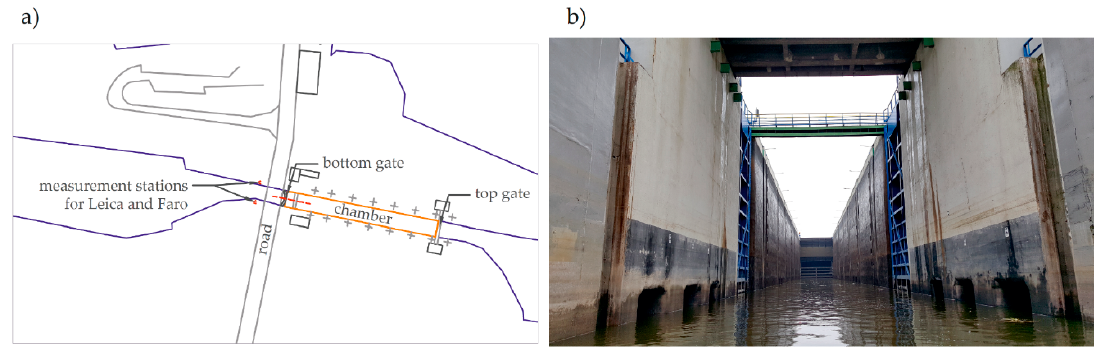
Figure 1. ( a ) Diagram of the lock in the Wloclawek river barrage; ( b ) View of the lock from the bottom side.